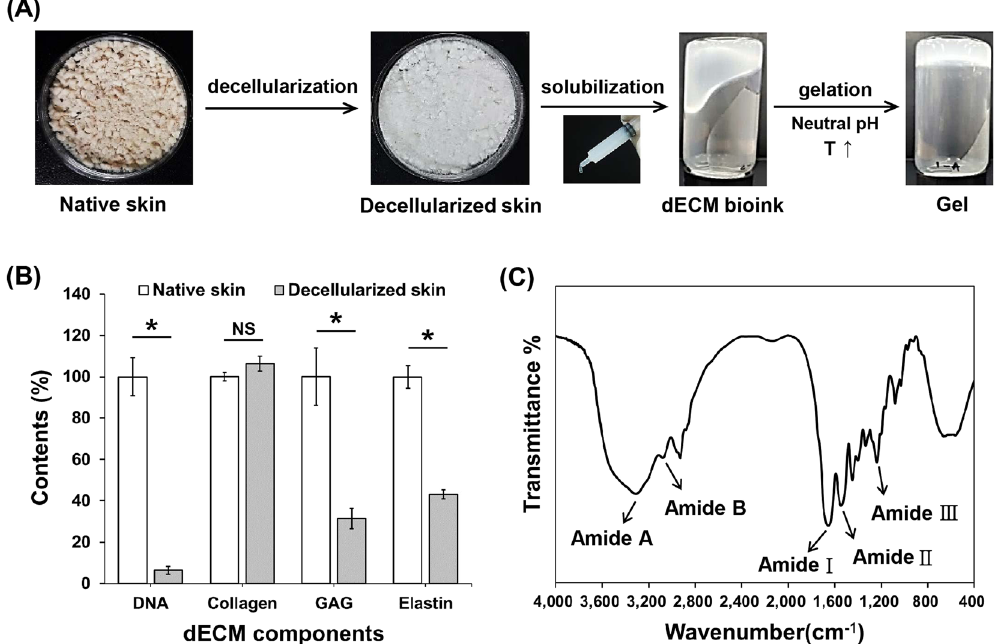
Figure 1. Characteristics of skin-derived dECM. ( A ) Process for extraction of skin-derived collagen bioink and gelation behaviour. ( B ) Quantitative analysis of dECM components. ( * p < 0.001) ( C ) FTIR spectra of the skin- derived